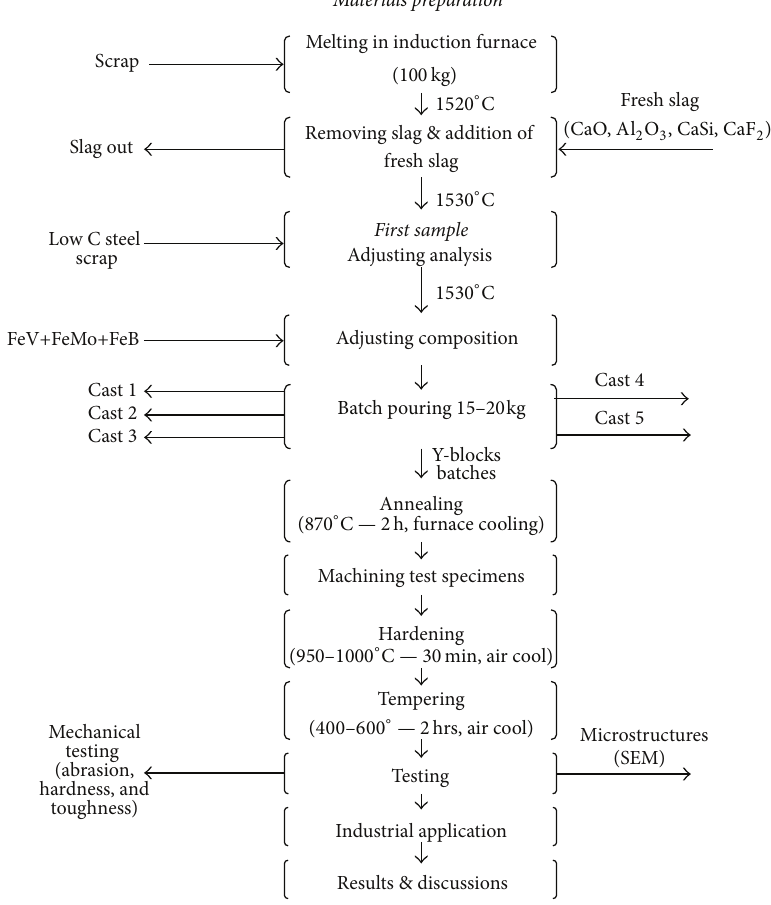
Figure 1: Overall plan of melting, casting, and testing of experimental